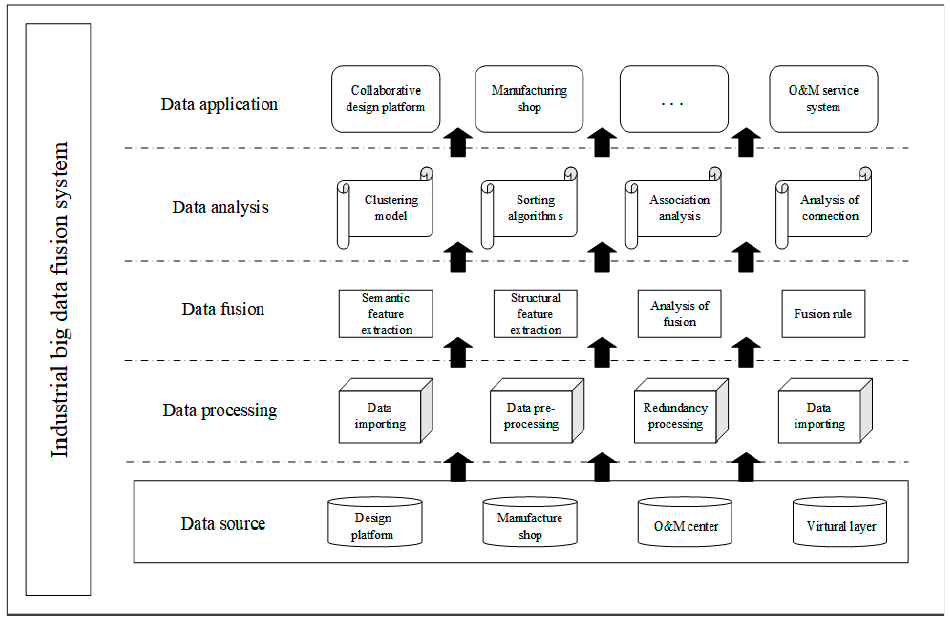
Figure 7. Data fusion and analysis architecture.